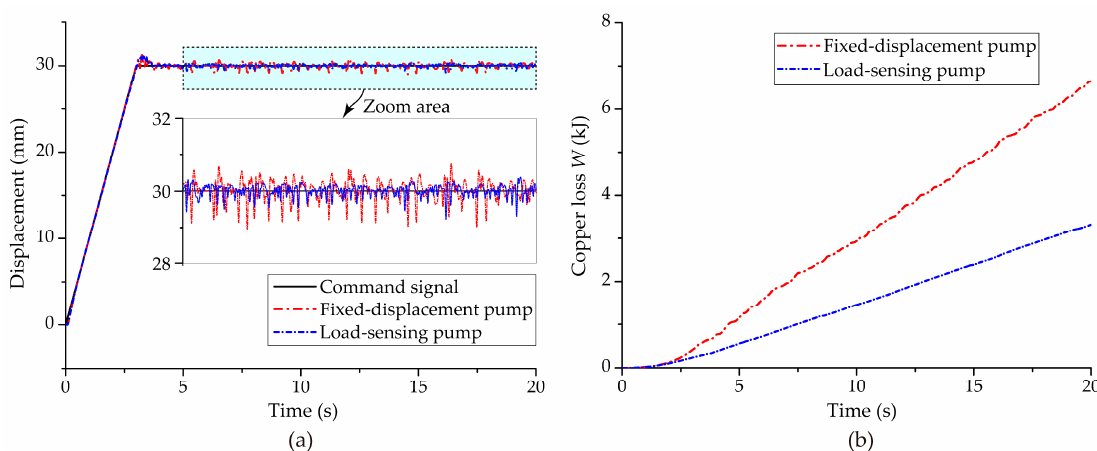
Figure 9. Experimental results for the EHA prototype: ( a ) Comparison of the hydraulic actuator displacement; ( b ) Comparison of the copper loss.